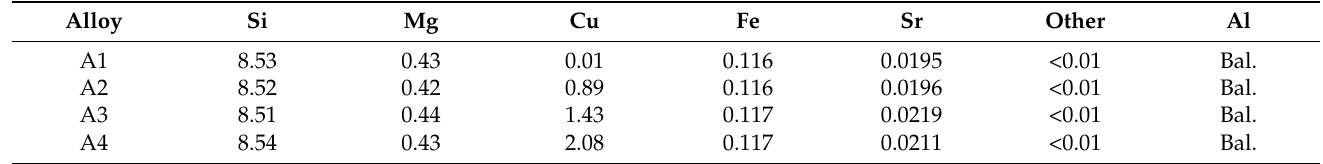
Table 1. Composition of the Al-Si-Mg-Cu alloys